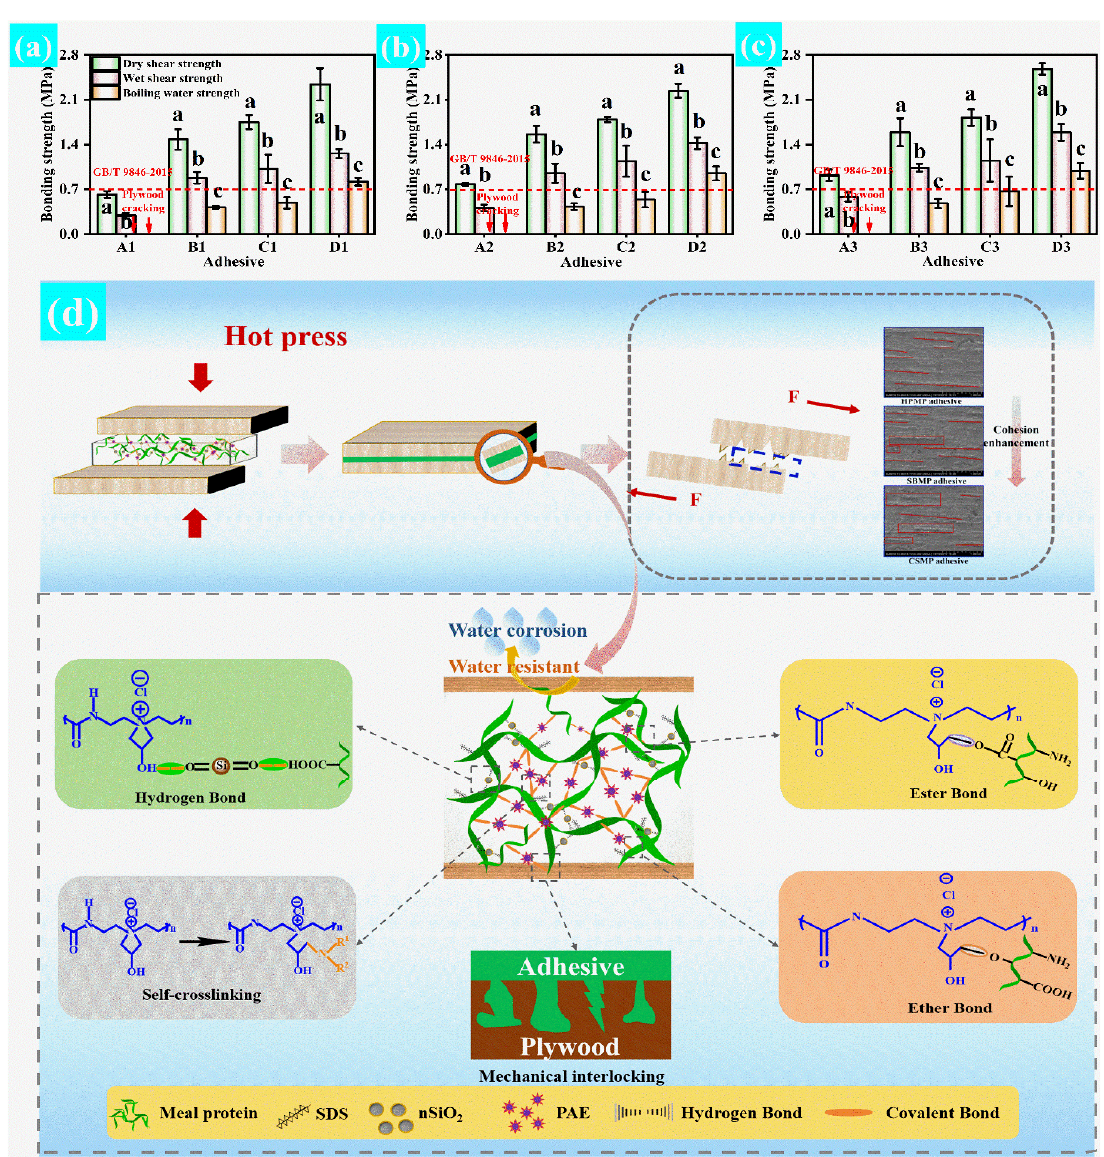
Figure 8. ( a – c ) Dry shear strength, wet shear strength, and boiling water strength of A1 ‐ pure